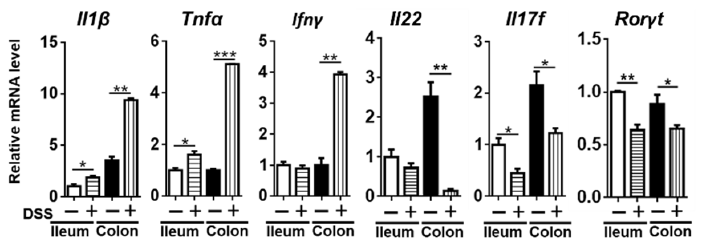
Figure 3. The expression of inflammatory genes in the ileum and colon of mice with or without DSS treatment. Data are expressed as mean ± SD. N = 9 per group. Student’s t-test. * p < 0.05, ** p < 0.01, *** p < 0.001.